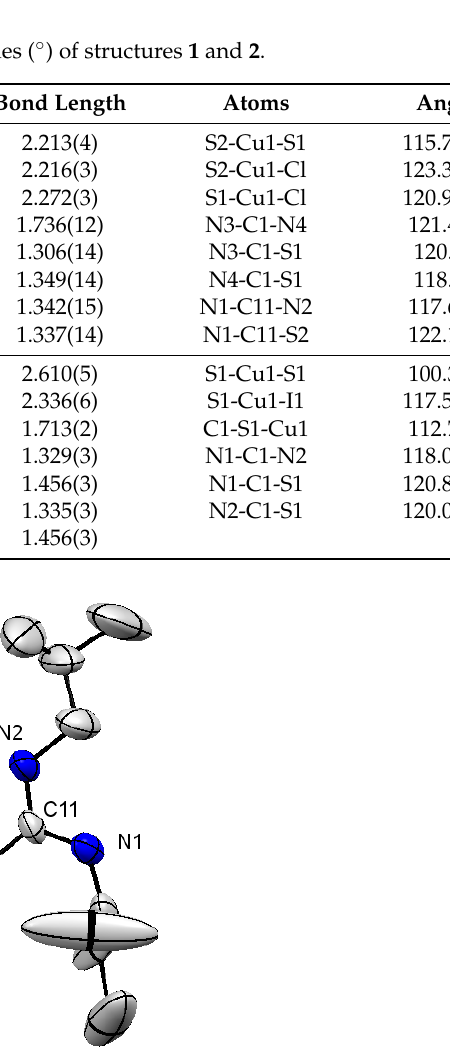
Figure 1. Molecular structure of Complex 1 , ball and stick representation with partial numbering scheme. All hydrogen atoms are omitted for clarity, summarized bond lengths (Å) and angles (°)